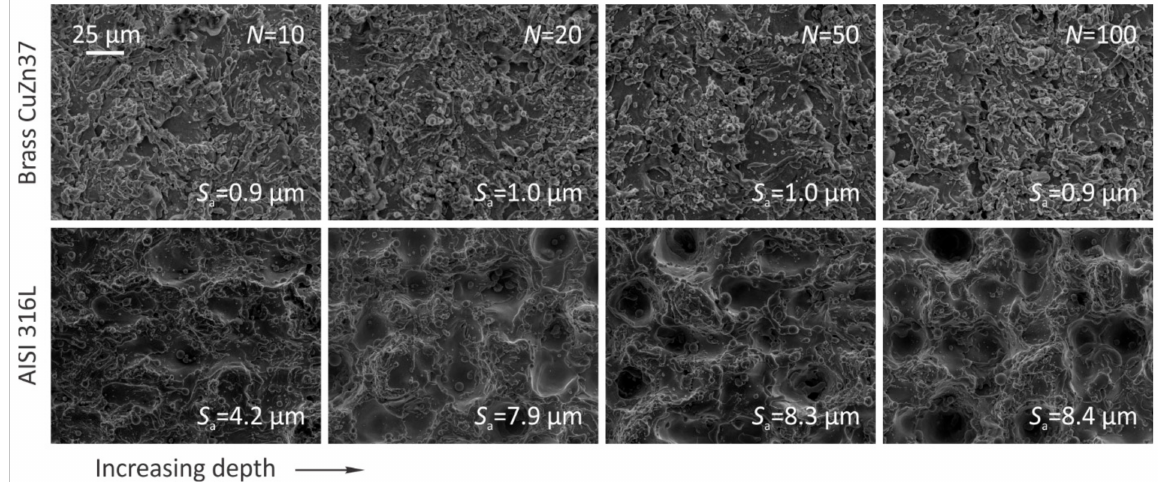
Figure 11. Bottom of the ablated areas as a function of scanning transitions.